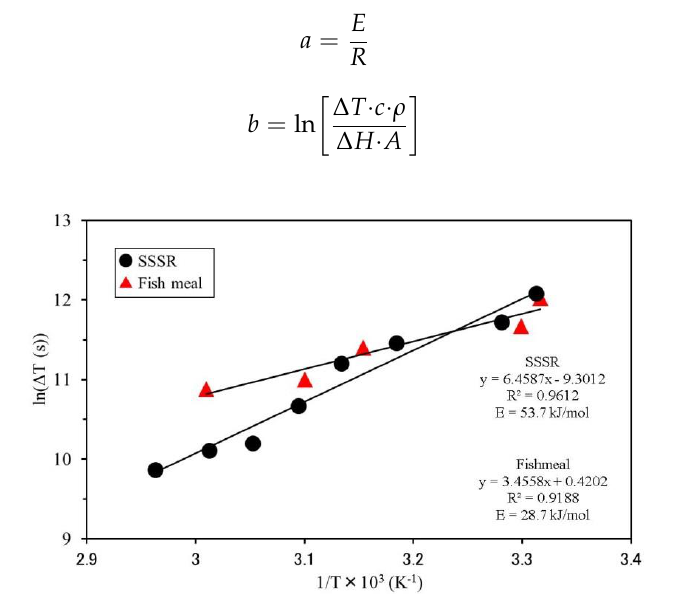
Figure22. Relationships between ln  t and 1/T for SSSR and fishmeal. Figure 22. Relationships between ln ∆ t and 1/T for SSSR and